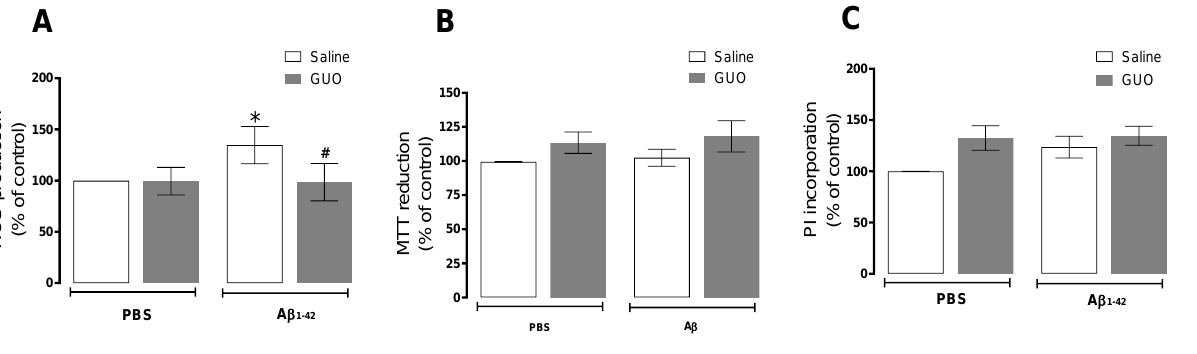
Figure 3. Guanosine prevents A β 1–42 -induced ROS production in mice hippocampal slices. Mice subjected to i.c.v. A β 1–42 infusion (400 pmol/site) received guanosine (GUO, 8 mg/kg, i.p.) for seven days. On the eighth day, animals were euthanized, and hippocampal slices were analysed for ROS production ( A ), cellular viability through MTT assay ( B ), and cellular membrane damage through Propidium iodide (PI) incorporation ( C ). Values expressed as mean + S.E.M (n = 6–9) * p ≤ 0.05 compared with vehicle-treated group. # p < 0.05 compared with A β 1–42 group. (Two-way ANOVA followed by Tukey’s test).